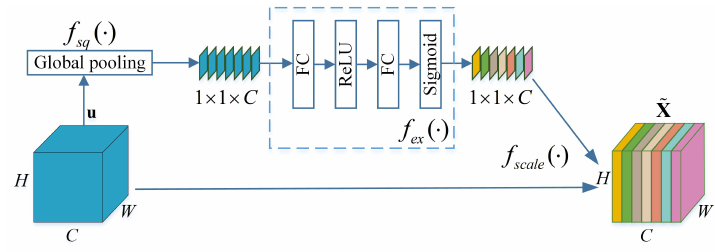
Figure 2. The SE